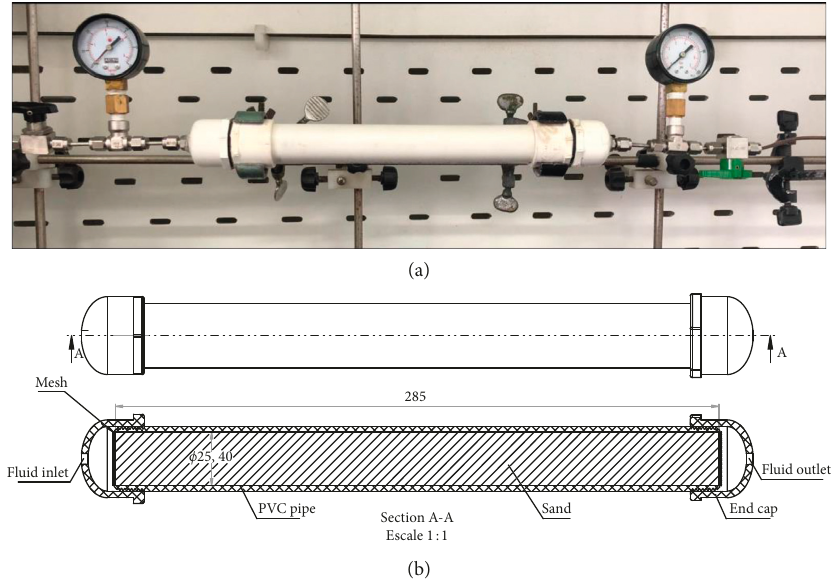
Figure 2: (a) Real sand-pack column with fittings valves and manometers; (b) map of the sand-pack column.